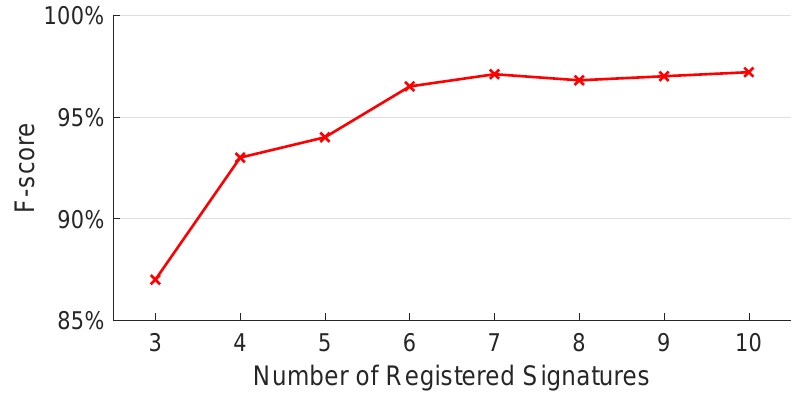
Figure 19. Authentication performances with different numbers of registered